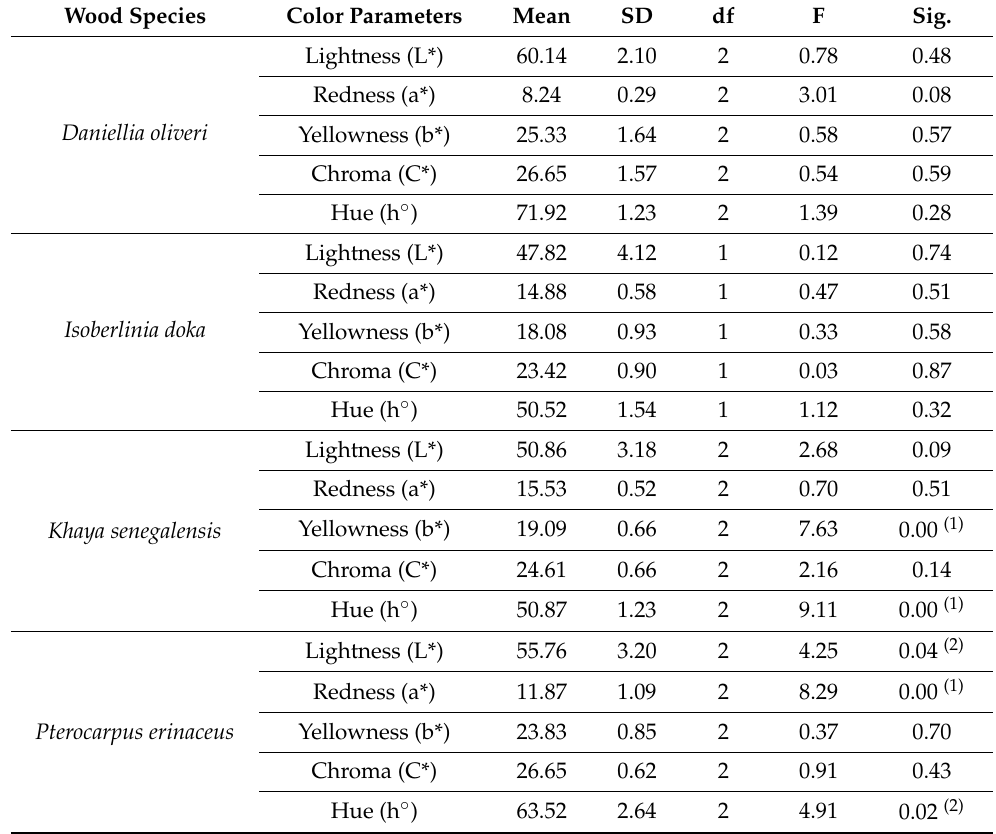
Table 2. Summary of the one-way ANOVA using the CIELab color parameters. Wood Species Color Parameters Mean SD Sig.